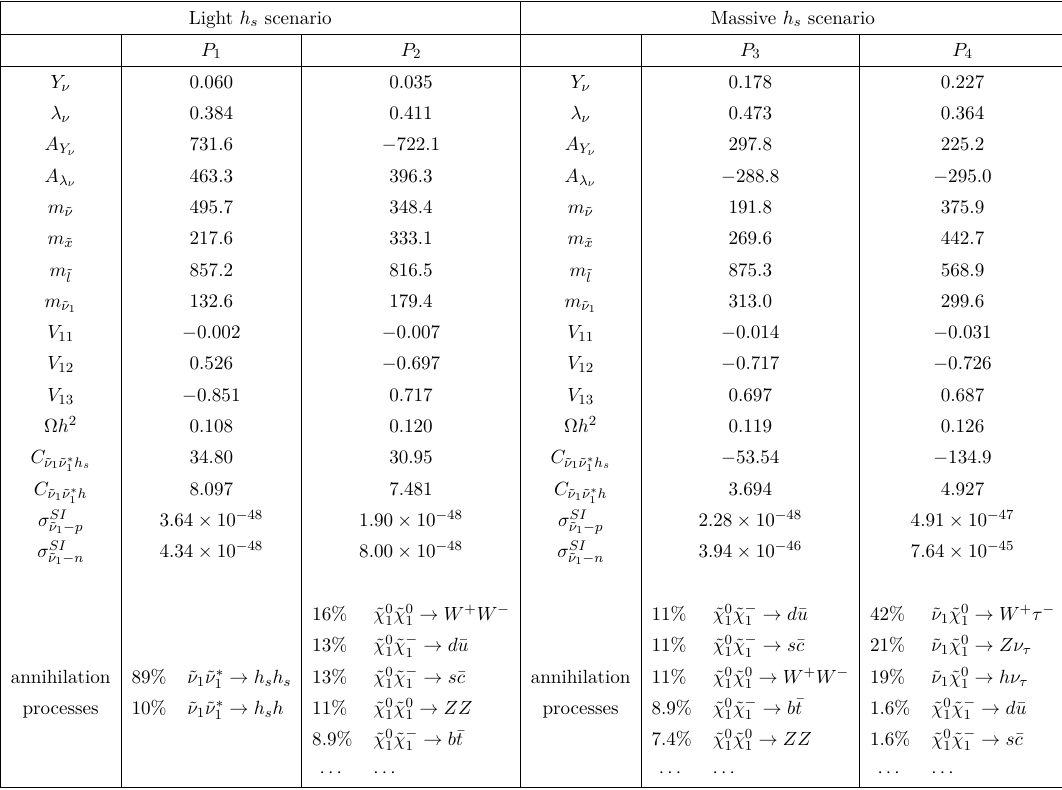
= 0 . The number before each µ X